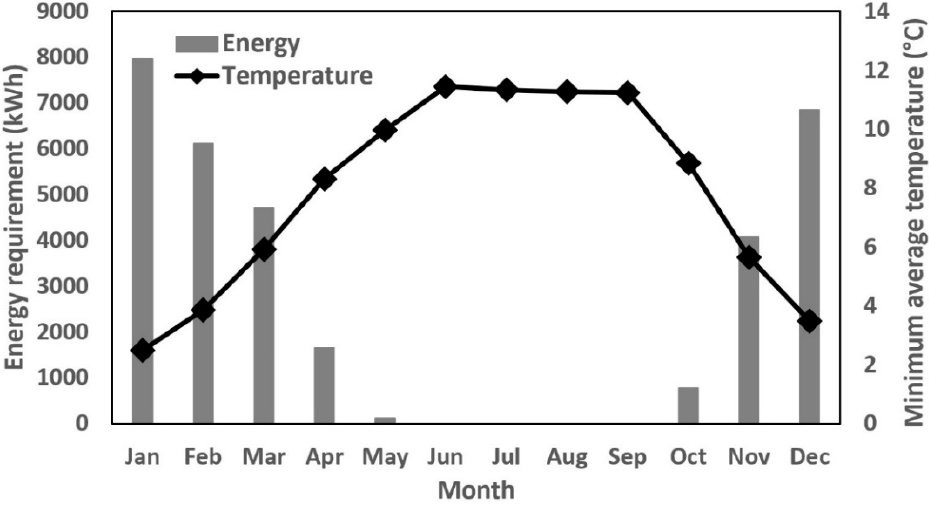
Figure 3. Annual variation in energy requirement for three daily hours.